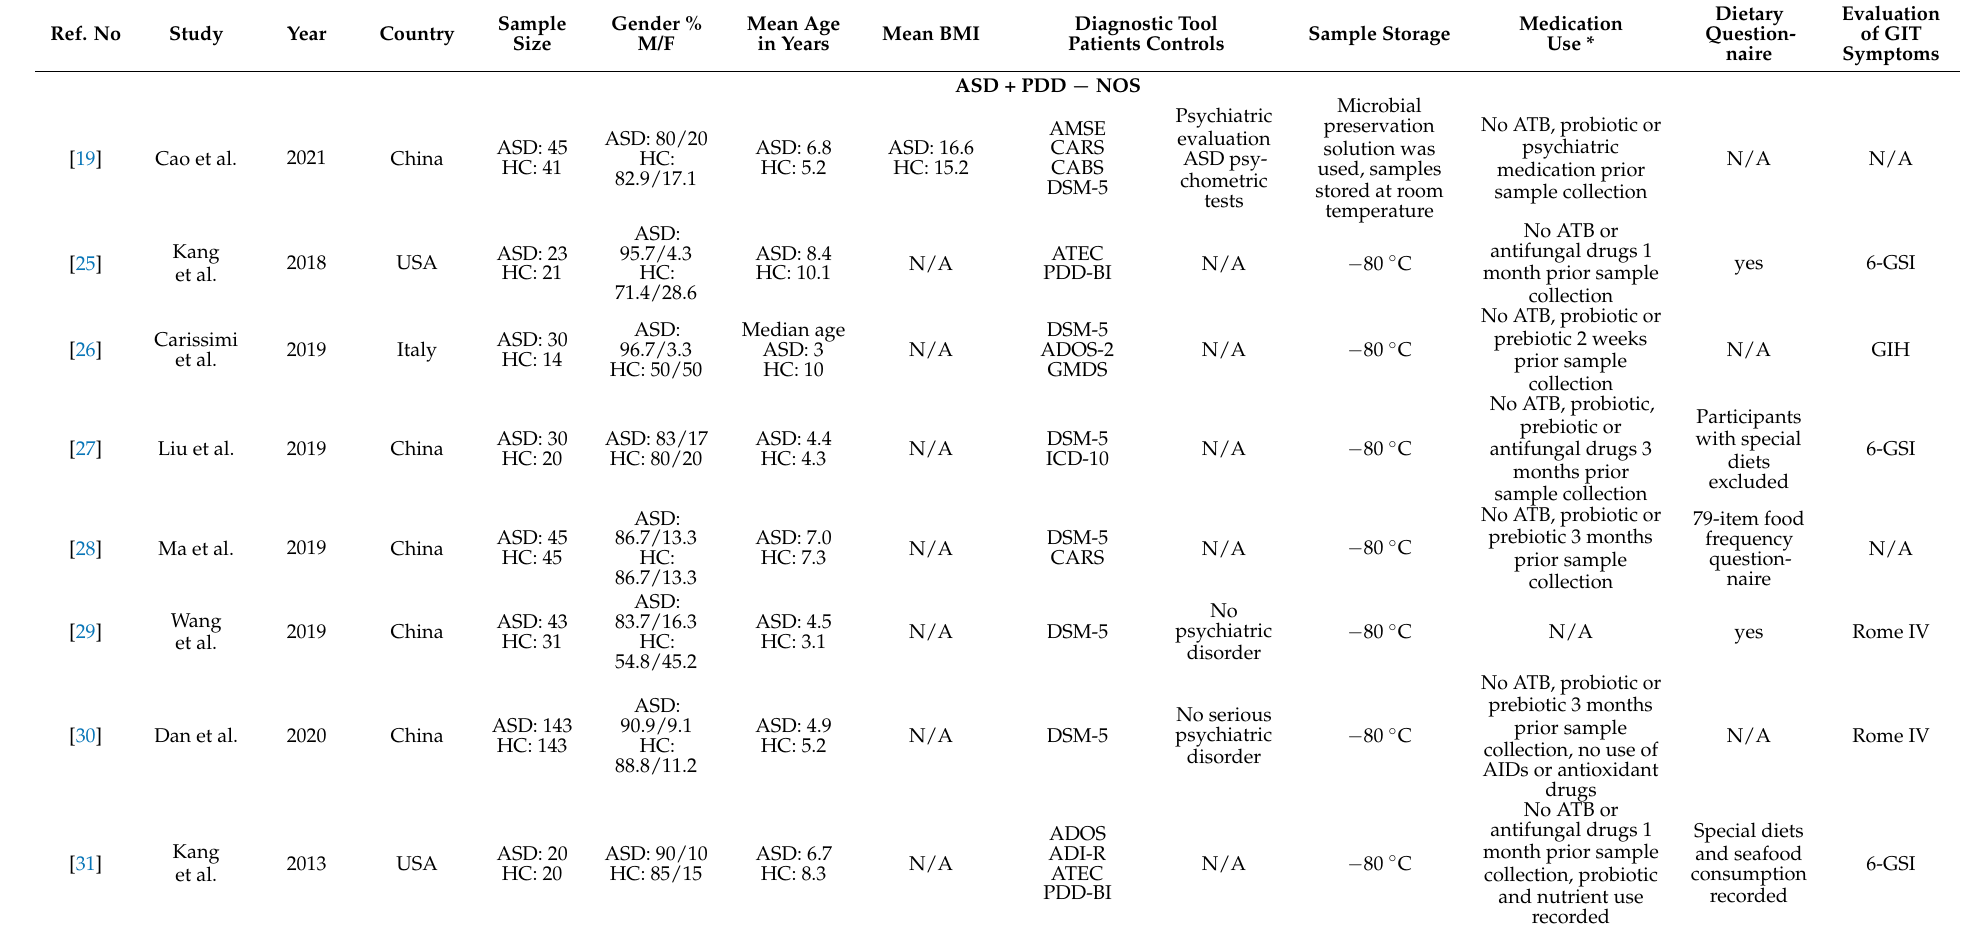
Table 1. Main characteristics of studies reporting about gut microbiota in children and adolescents with psychiatric